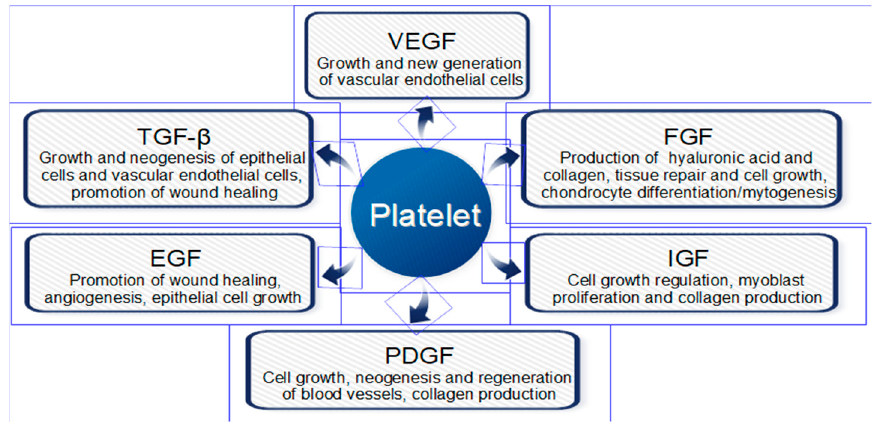
Table 1 overviews the main characteristics of the synthesized polymers. Table 1. Overview of the main characteristics of VinylSulfTC_n copolymers, as determined by 1 H-NMR, Gel Permeation Chromatography and light